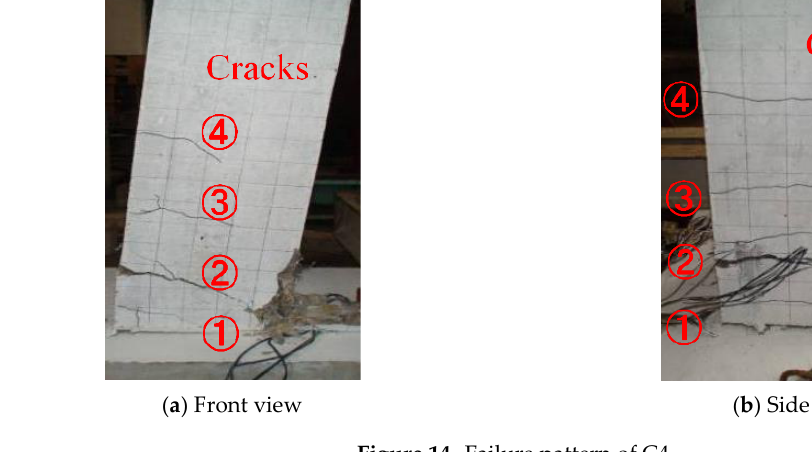
Figure 14. Failure pattern of C4.